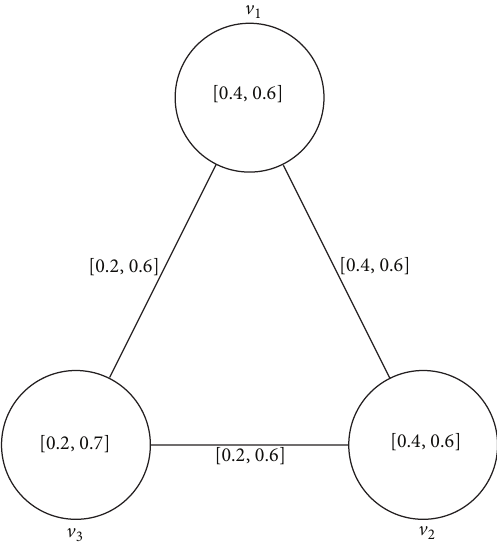
Figure 8: 𝐺 is not neighbourly irregular, but it is complete.